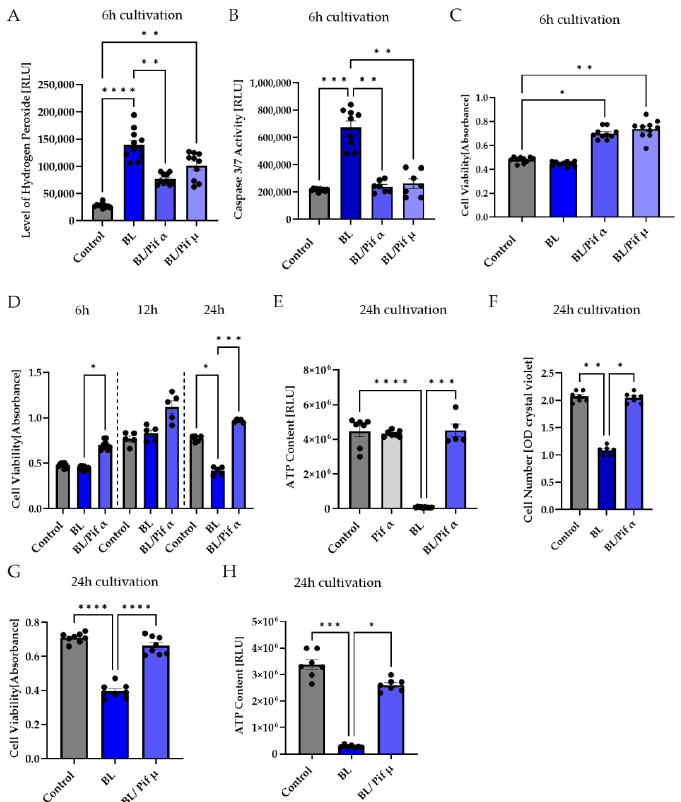
Figure 6. Inhibition of p53 reduced apoptosis in porcine Müller cell-derived cells. ( A – H ) MCs were exposed to blue light (BL, 30 mW/cm²) for 1.5 h and further cultivated for the indicated timepoints. Treatment with 1 µ M pifithrin α (Pif α ) or 10 µ M pifithrin µ (Pif µ ) immediately after exposure resulted in ( A ) decreased BL-induced oxidative stress levels 6 h after exposure, but only treatment with Pif α was able to significantly reduce the level of hydrogen peroxide. ( B ) A significantly reduced caspase 3/7 activity back to control levels was determined with each inhibitor. ( C ) Cell viability in MCs was enhanced by Pif α or Pif µ treatment. ( D ) Pif α incubation after BL exposure resulted in significantly induced cell viability compared to BL-exposed cells in a time-dependent manner. Cell viability was always higher compared to unexposed controls. Each timepoint represents an independent experiment. ( E ) The strong decrease in ATP content in MCs 24 h after BL exposure could be rescued by immediate treatment with Pif α . Treatment of unexposed MCs with Pif α did not alter ATP content. ( F ) Pif α treatment could rescue significantly decreased cell numbers 24 h after BL exposure. ( G ) Cell viability was also significantly enhanced due to treatment with Pif µ , compared to BL-exposed MCs. ( H ) Evaluation of ATP content revealed a significant increase due to Pif µ treatment 24 h after BL exposure, compared to BL-exposed MCs. Bar graphs represent the mean values and SEM. The experiments were repeated three times with similar results. Statistical differences are indicated as follows: * p < 0.05, ** p < 0.01, *** p < 0.001, and **** p < 0.0001 compared to control/BL, according to Welch’s one-way ANOVA or Kruskal–Wallis